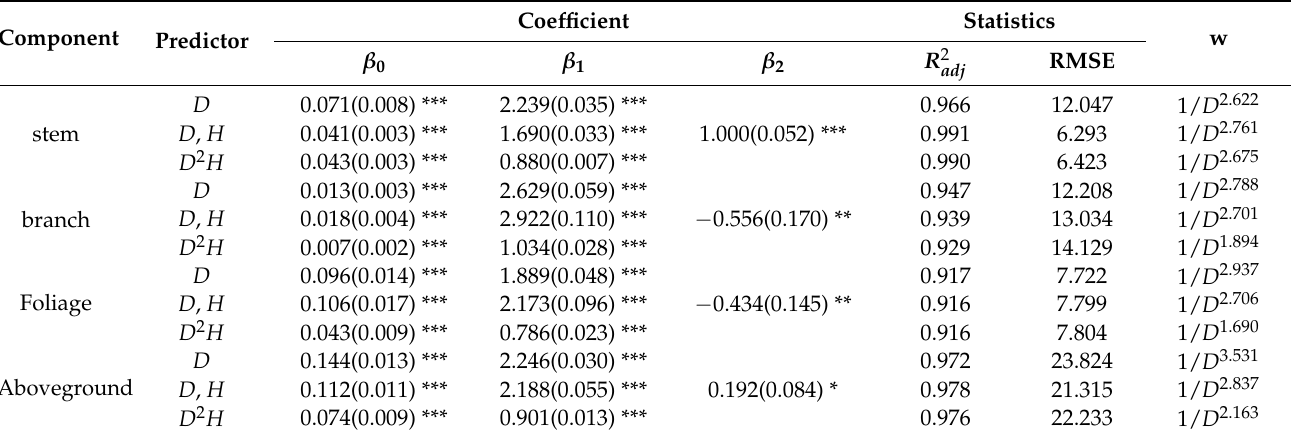
Figure 3. Scatter plot of component-specific and total aboveground biomass against potential inde- pendent variables. Table 2. Regression coefficients with standard errors (in parentheses) and fitting statistics through the independently fitted procedure using weighted regression.